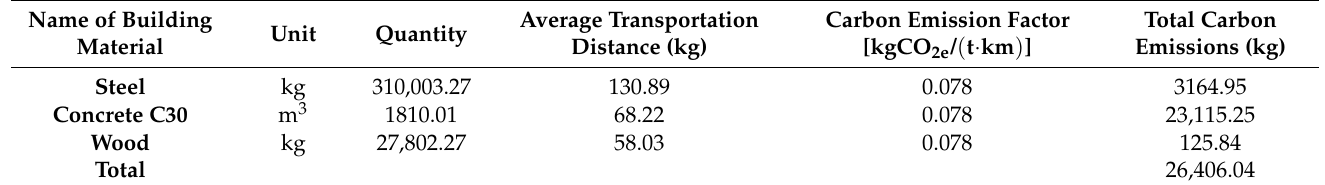
Table 6. Carbon emissions from the transportation of major building materials.